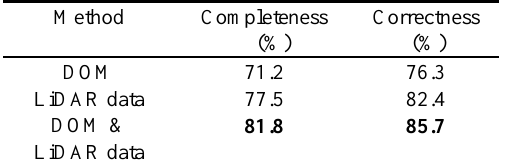
Table 3. Completeness and correctness of the three